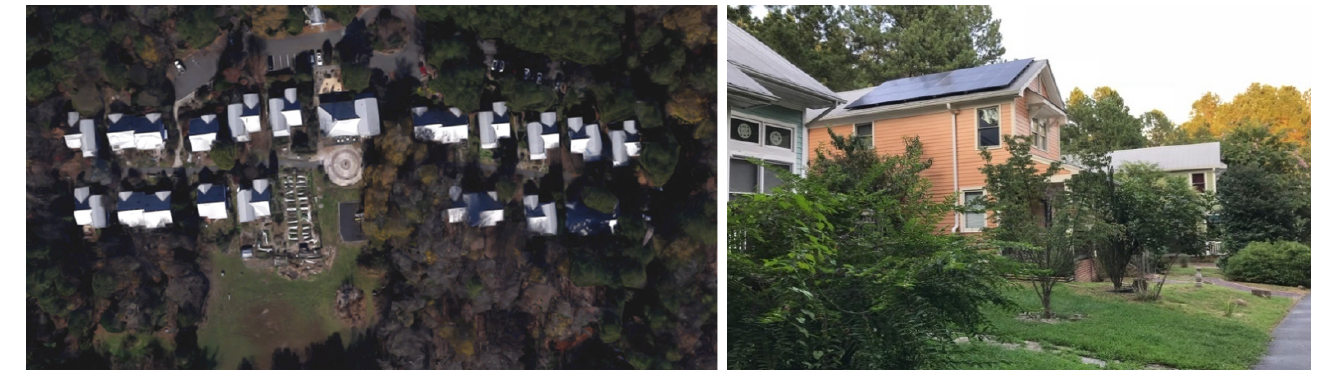
Figure 5. Eno Commons. Houses in Eno Commons generally spread along two pedestrian paths.